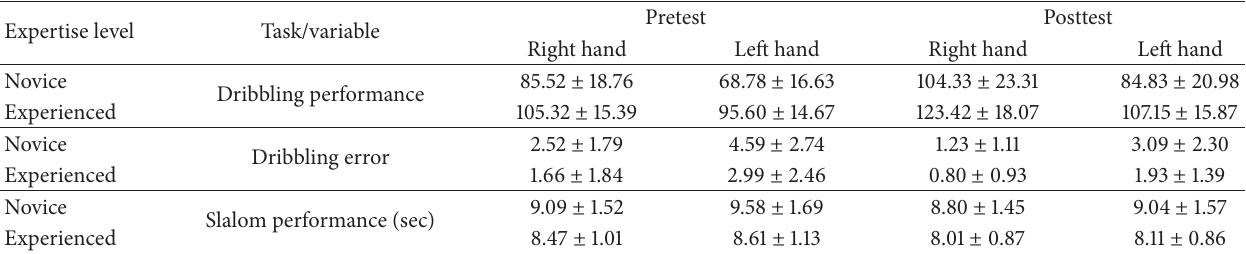
Table 1: Performance scores for all test variables for experts and novices independent of condition. Shown are mean values along standard